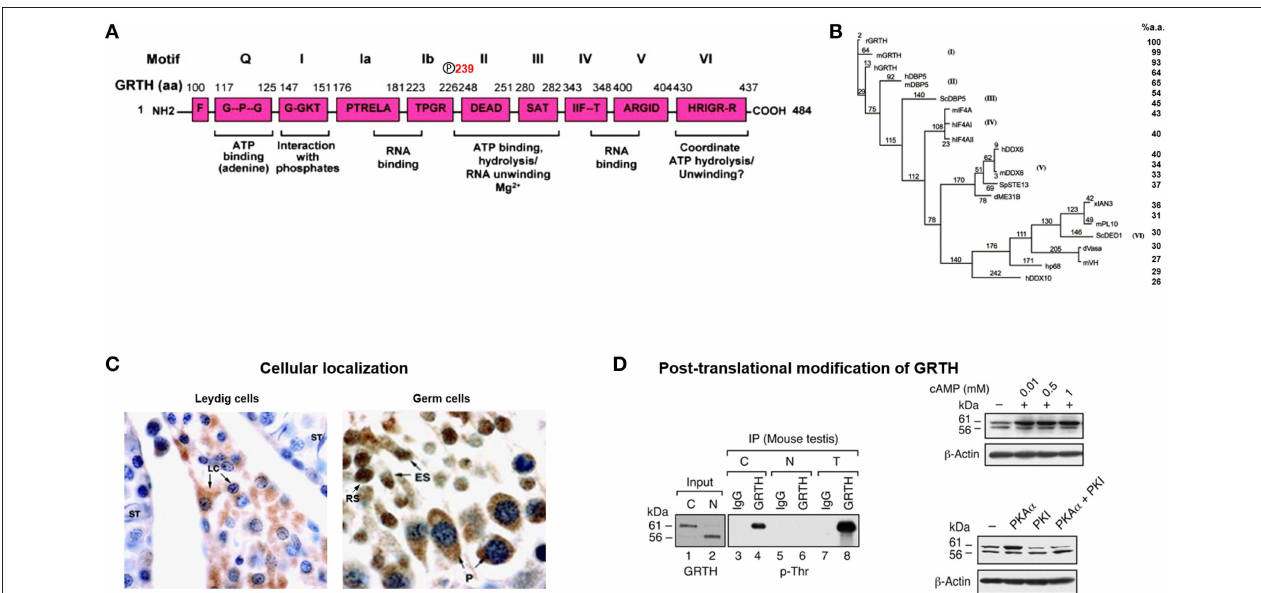
FIGURE 1 | GRTH structure, cellular localization, and post-translational modification. (A) Schematic representation of the conserved amino acid motifs shared by GRTH with members of the DEAD-box family of proteins. Nine conserved motifs are indicated as (Q, I, Ia, Ib, II–VI). The amino acid position T239 showing phospho-modification in GRTH which is located outside the conserved domain. (B) Phylogenic analysis of members of DEAD-box family of RNA helicase. Maximum parsimony analysis of the alignment of 20 members of DEAD family was constructed using the neighbor-jointing method of PAUP 4.0. The mouse and human GRTH proteins display sequence similarity to the rat of 98.8 and 93.4%, respectively ( 7). (C) Cellular localization in mice testis of GRTH protein in the interstitial compartment and in different cell types in the rat seminiferous tubule (5). GRTH expression is noticed in Leydig cells (LC), pachytene spermatocytes (P), round spermatids (RS), and elongating spermatids (ES). (D) Western blot analysis (left) showing pull-down of GRTH protein from mice total testicular lysates (T) and purified cytoplasmic (C) or nuclear (N) fraction using GRTH specific antibody by immunoprecipitation. GRTH; p-Ser, p-Thr, and p-Tyr, phosphoantibodies were used to develop the blot. Right. Western blot showing effect of cAMP treatment on COS-1 cells overexpressing GRTH (above). Western blot showing increased on post-translational modification (phospho) of overexpressed GRTH protein species by co-transfected PKA catalytic subunit (pGRTH, 61 kDa and non-phospho GRTH, 56 kDa) prevented by PKA inhibitor (PKI) (below) in COS-1 cells